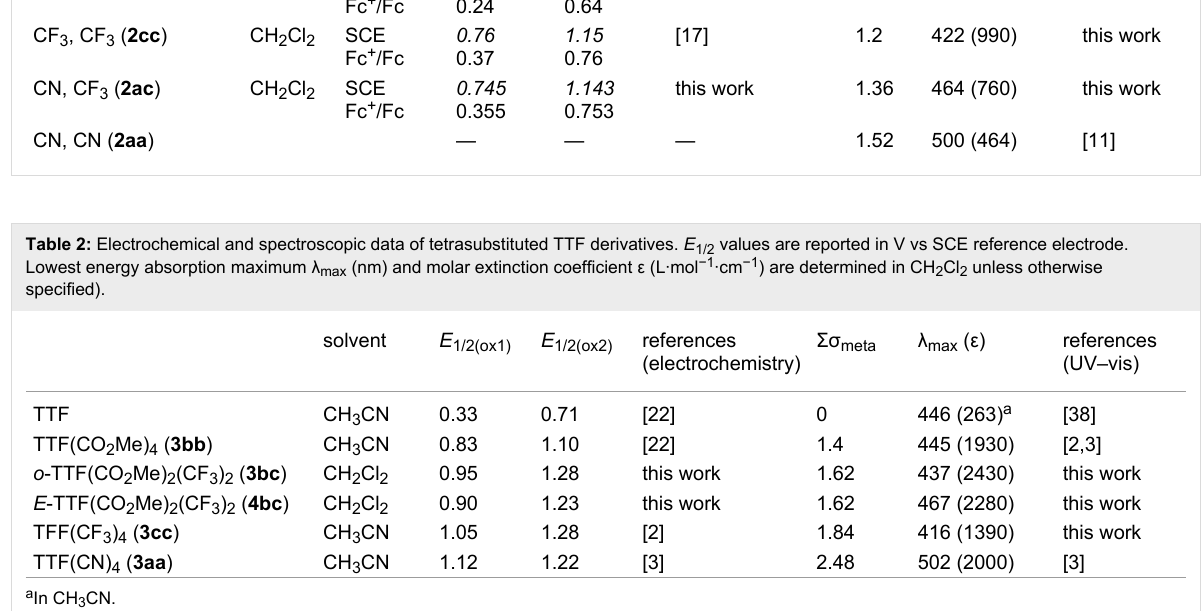
TFF derivatives are lightly orange colored, while the ester